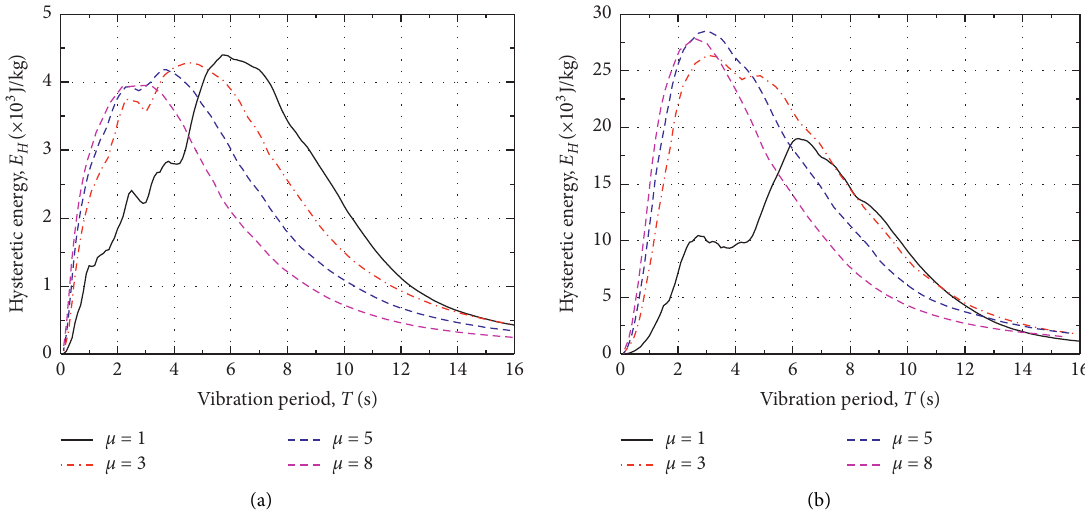
Figure 16: Hysteretic energy spectra affected by ductility coefficient. (a) Near-fault pulse-like ground motions. (b) Far-field harmonic ground motions.